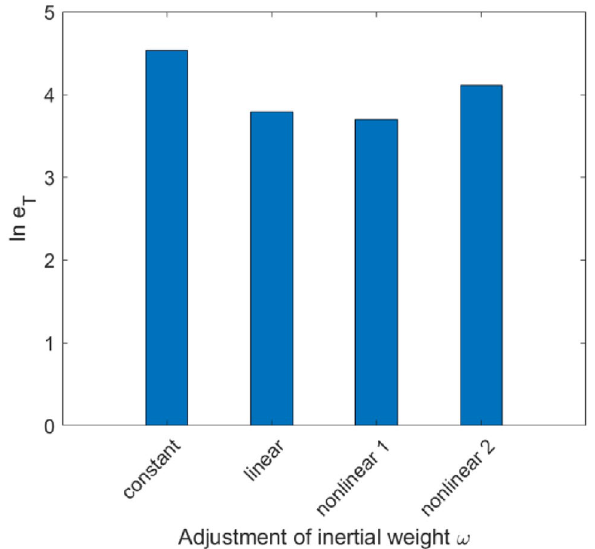
Figure 9. The parameter error comparison when the inertia weight is a constant, a single determined linear function, and two sets of dynamic nonlinear concave functions